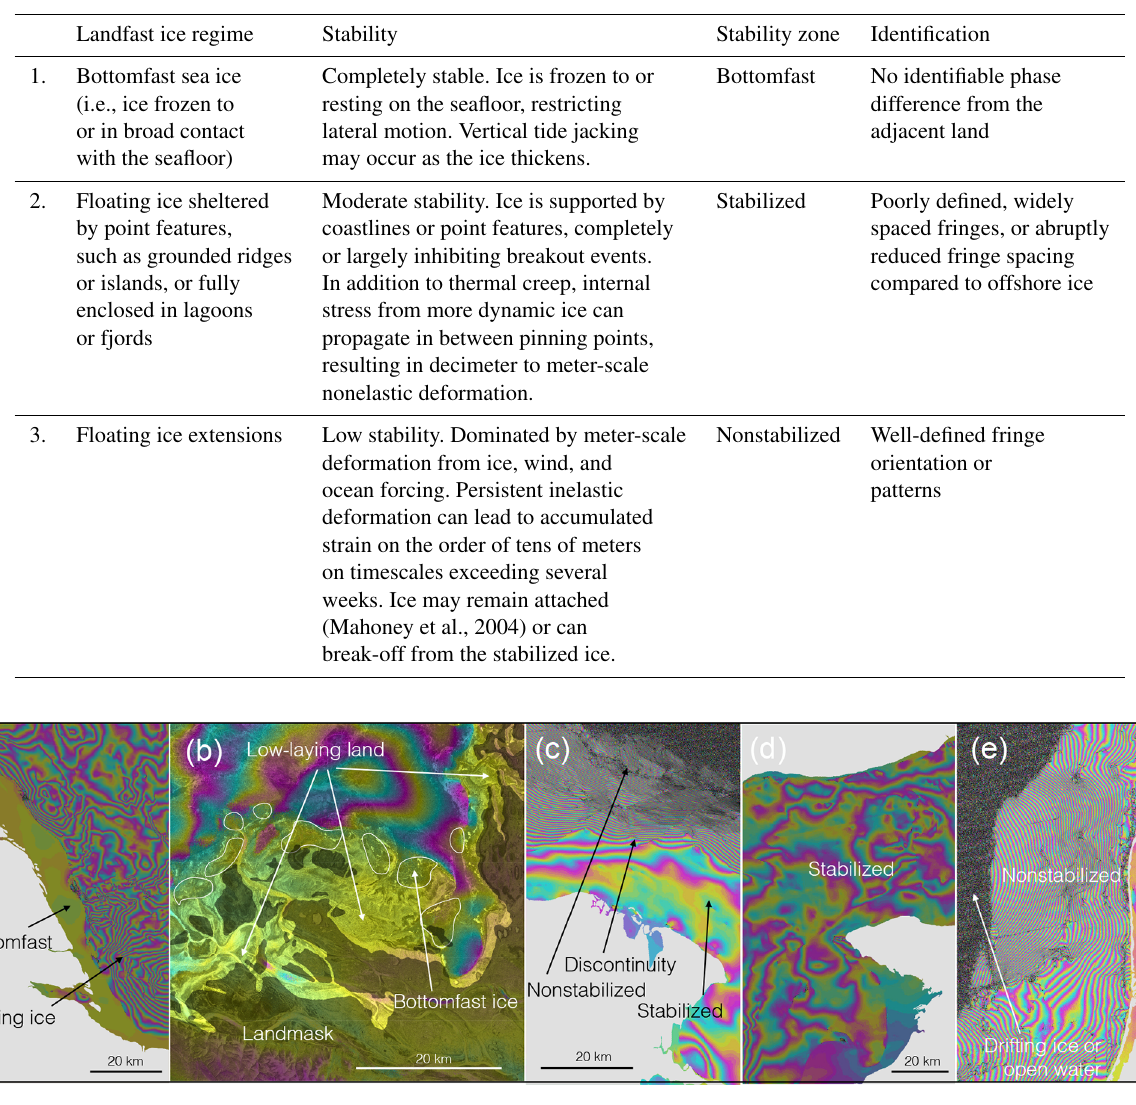
Figure 3. (a) Example of interferometric phase response over bottomfast ice. (b) Phase/backscatter composite near a delta. This example exhibits a poor match between the landmask (transparent black shading) and low-lying coastal areas. Here, bottomfast ice (white outline) had to be mapped against the coastline, as identified in the backscatter data. (c) Example of stabilized ice as identified based on a phase discontinuity. (d) Example of stabilized ice as identified by low fringe density and nonconsistent fringe patterns. (e) Example of nonstabilized ice as identified by high fringe density. Land is masked out in light gray in panels (a, c, d, e)